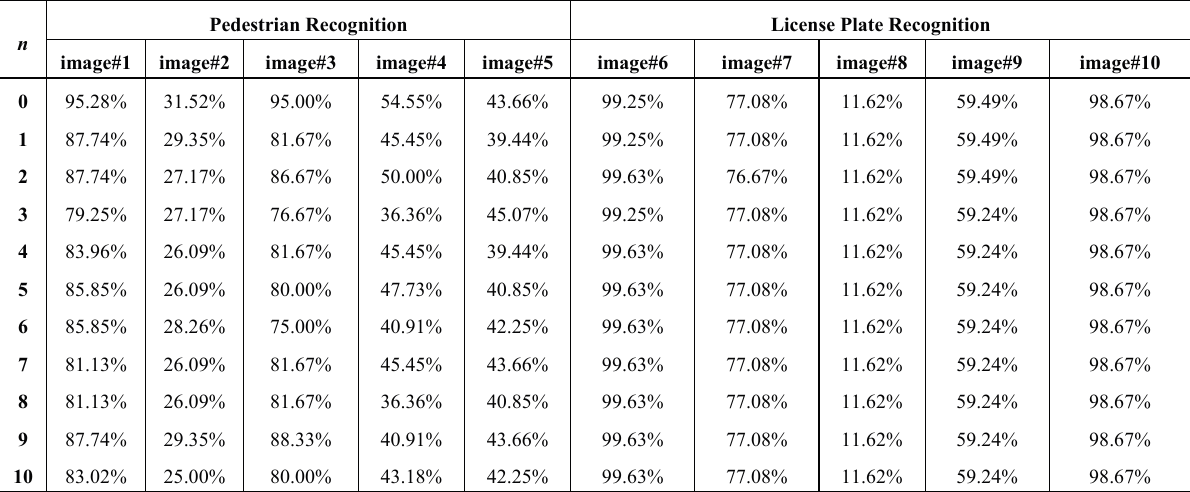
Table 5. Comparison of recognition accuracy for number of D-ROI frame